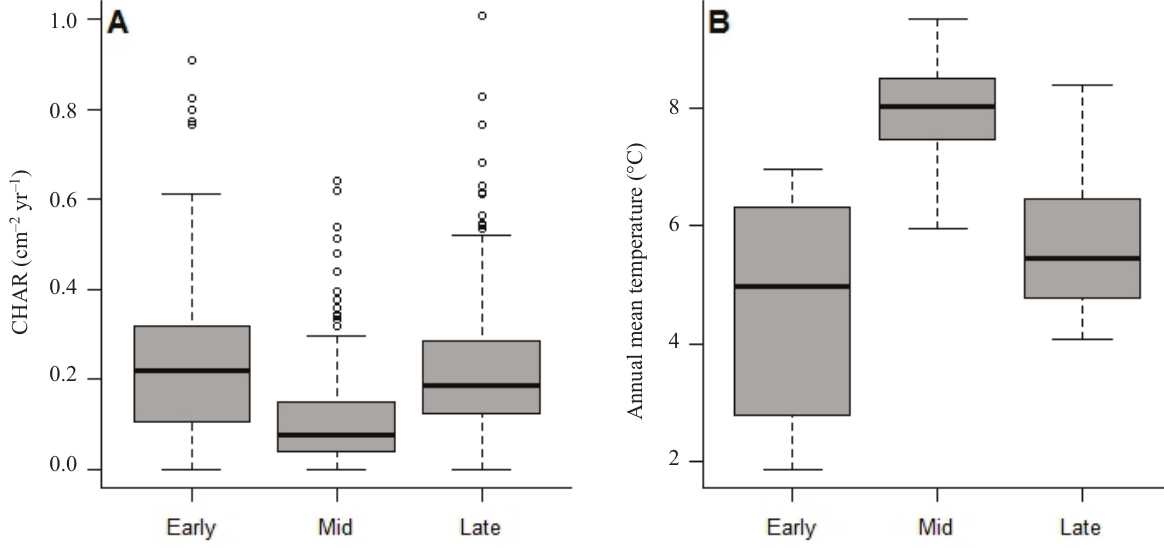
Fig. 5. A , Bricu I CHAR data (particles cm –2 yr –1 ) reflecting fire during the early (11 700–8200 cal yr BP), middle (8200–4200 cal yr BP) and late (last 4200 years) Holocene; B , pollen­based mean air temperature ( ° C) pattern for the Holocene in eastern Latvia (Stivrins et al.